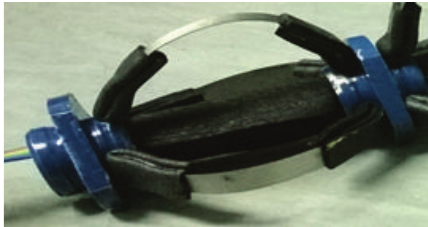
Figure 10: Prototype of the EAP-based flexible actuator.